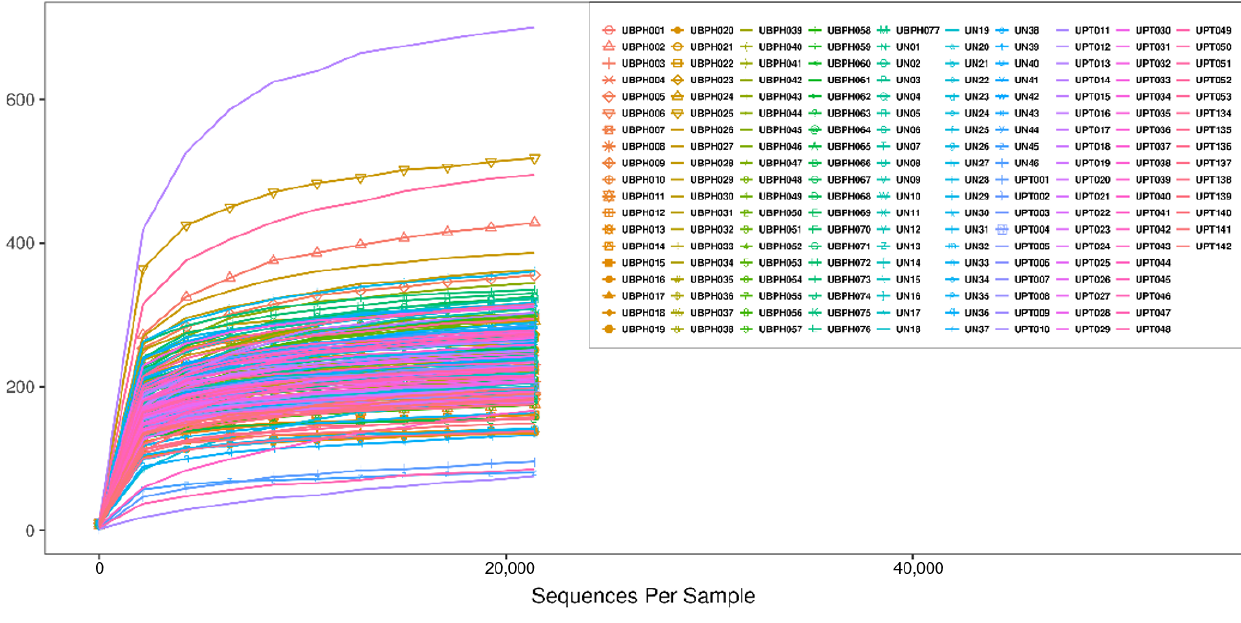
Figure 2. Rarefaction curve of urine samples. Sequence number threshold of the urine sample was set at 21,410. Each line represents a urine sample collected from a project participant. UBPH: Urine from a patient with BPH. UN: Urine from control group. UPT: Urine from a patient with prostate cancer.